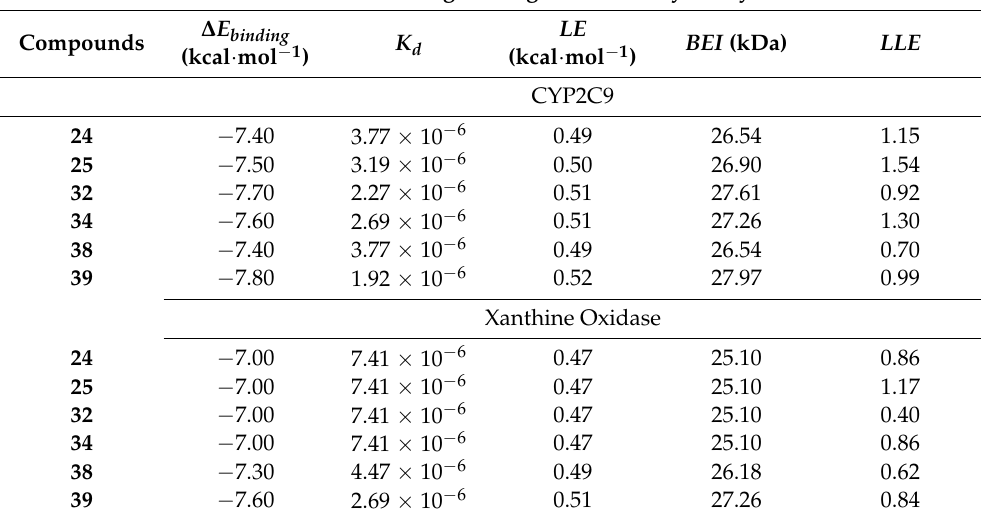
Table 3. Molecular docking results for the best six compounds of VPEO regarding CYP2C9 and xanthine oxidase. Intermolecular docking energy values ( ∆ E binding ), K d values, Ligand Efficiency ( LE ), Binding Efficiency Index ( BEI ), and Lipophilic Ligand Efficiency ( LLE ) for the CYP2C9 and xanthine oxidase complexes. Docking and Ligand Efficiency Analysis